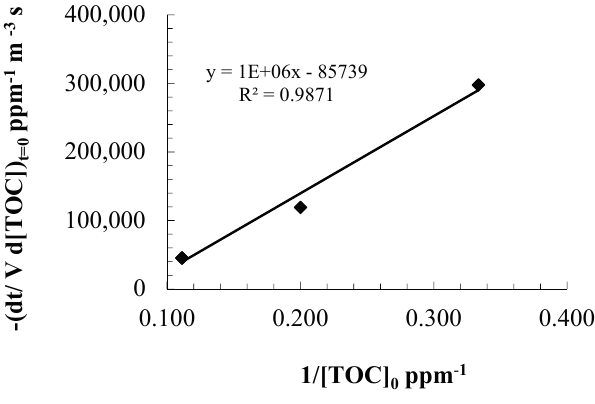
Figure 7. Linear regression for fitting parameters of the kinetic